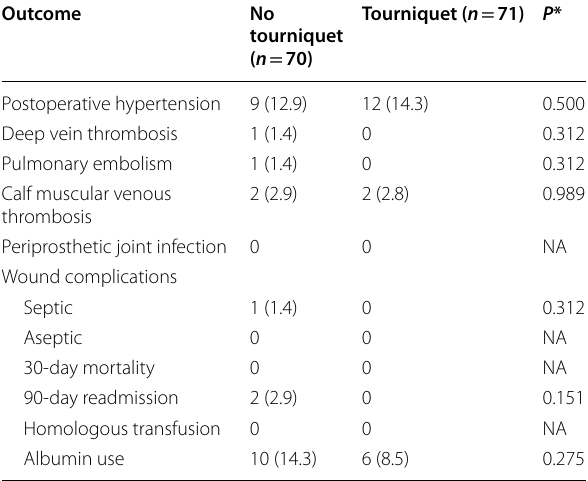
Table 5 Comparison of complications, homologous transfusions, and albumin use between the two